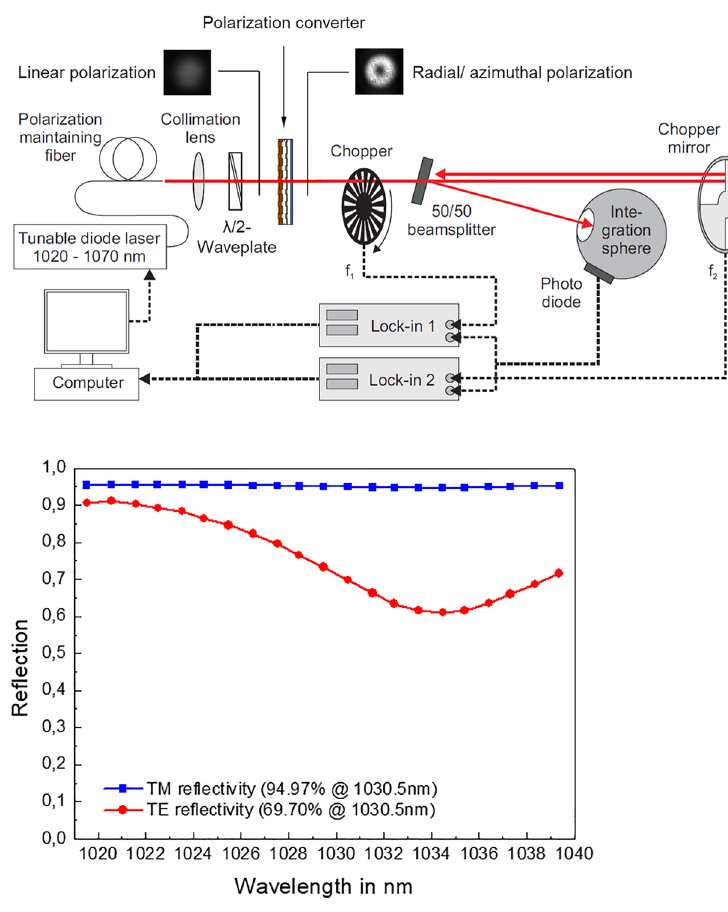
Figure 8: Measured radial (TM) and azimuthal (TE) reflectivities versus